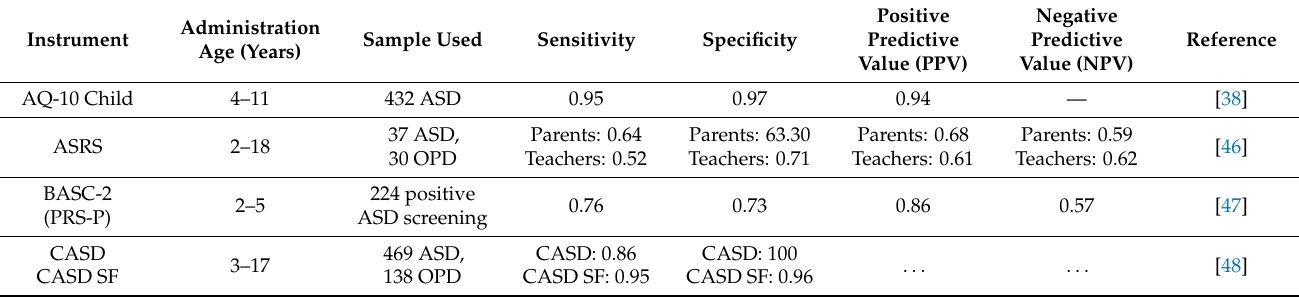
Table 2. Screening instruments used in children older than 2